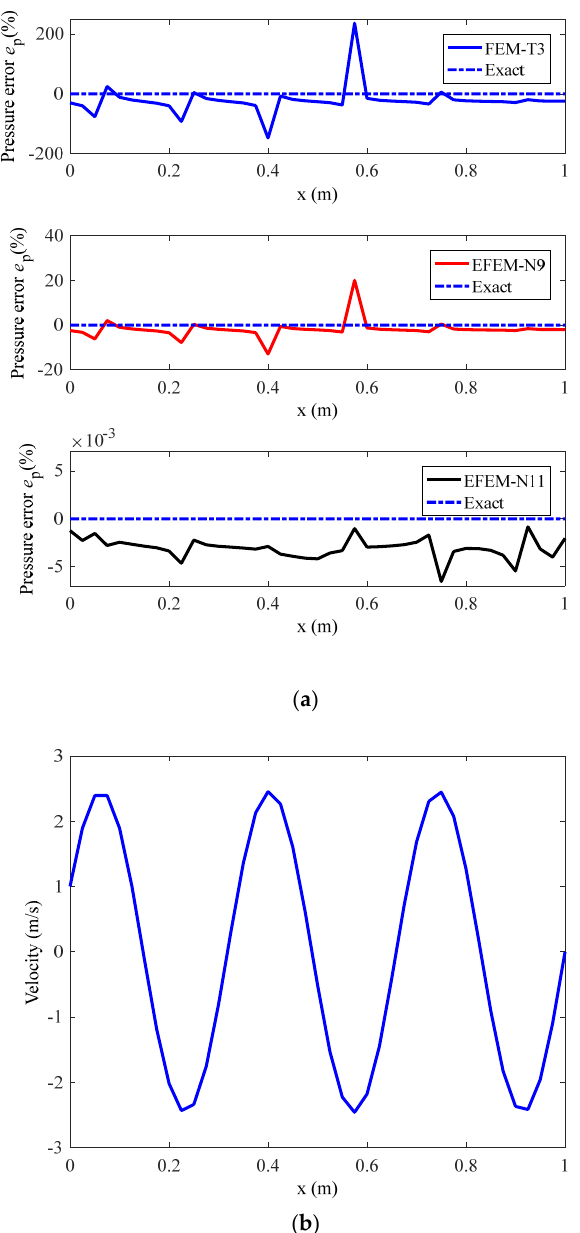
Figure 7. The calculated relative error results from di ff erent numerical techniques for the frequency value f = 4400 Hz: ( a ) the relative error results and ( b ) the corresponding exact acoustic particle velocity distributions.